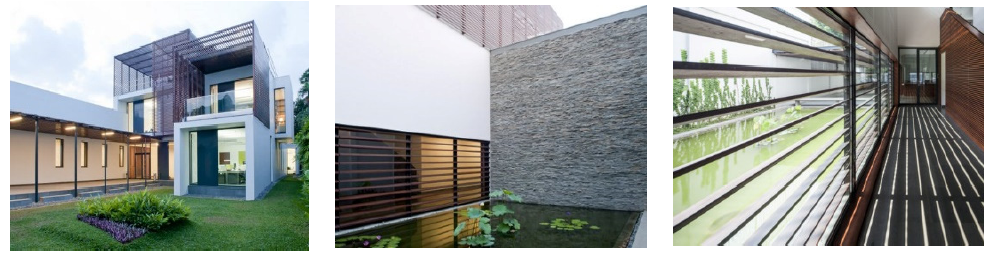
Figure 2. Passive office building in Jakarta [19] .